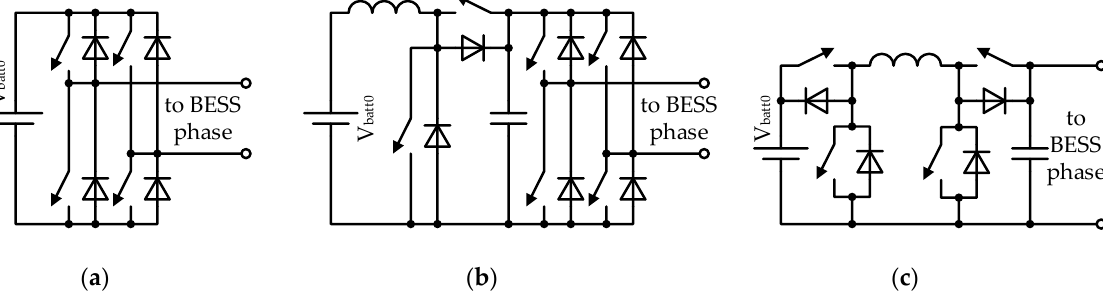
Figure 14. Power converters for multilevel converter building blocks: ( a ) full bridge or H-bridge, ( b ) H-bridge with correcting synchronous buck converter, ( c ) unipolar bidirectional converter [108].